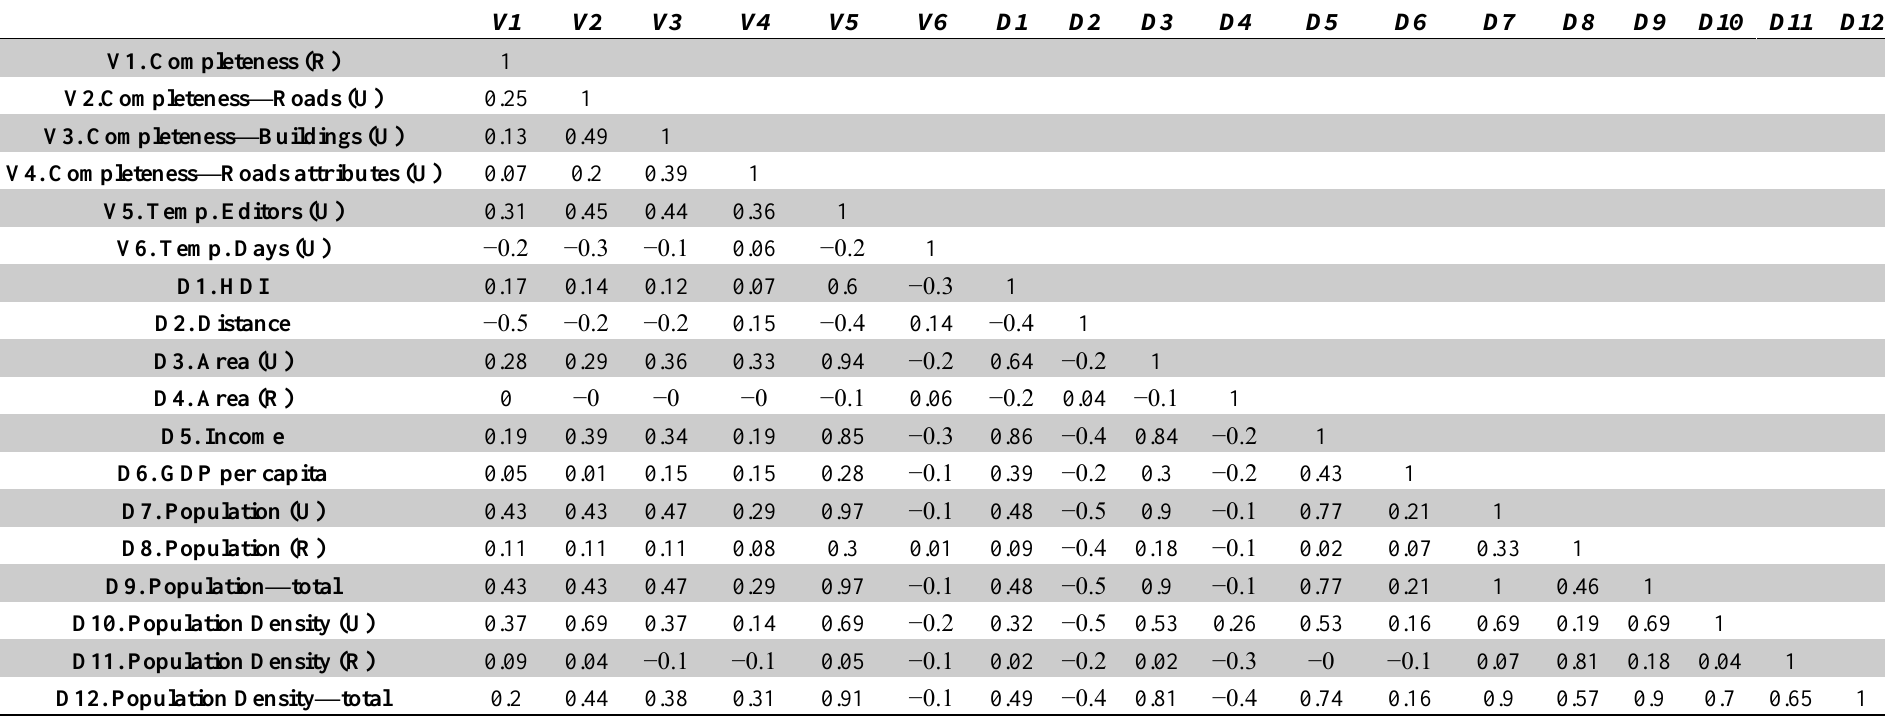
Table 5. Correlation between data quality observations and demographic